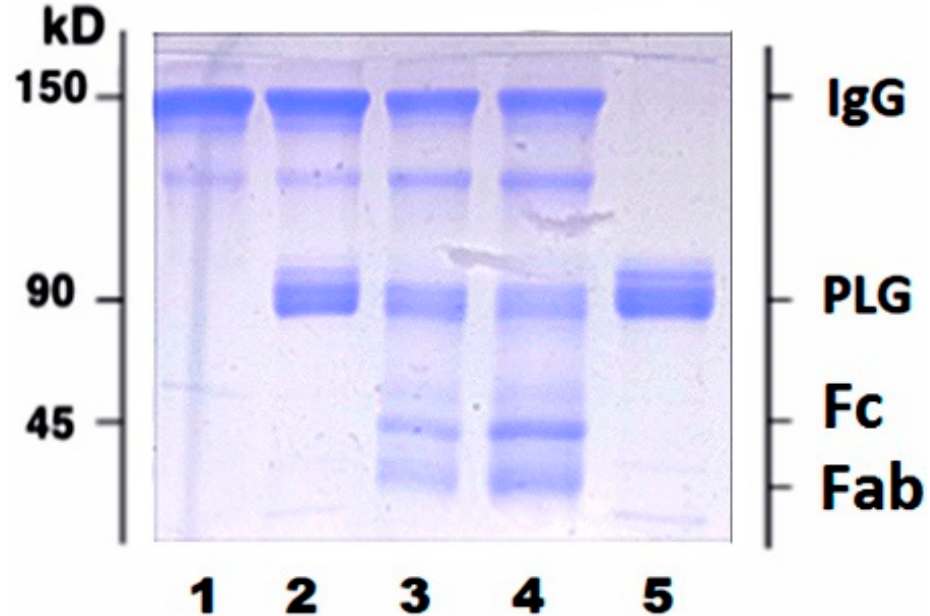
Figure 2. Plasmin-mediated proteolysis of purified human IgG results in appearance of new bands with low MW (<45 kDa). Purified IgG were treated with PM as described in Methods section and analyzed using 10% SDS-PAGE under non-reducing conditions. 1 , untreated IgG; 2 , IgG plus activated PLG without incubation; 3 , IgG plus activated PLG after 1 h incubation; 4 , IgG plus activated PLG after 6 h incubation; 5 , PLG. Bands with MW < 45 kDa in lanes 3 and 4 correspond to Fc and Fab fragments of IgG.